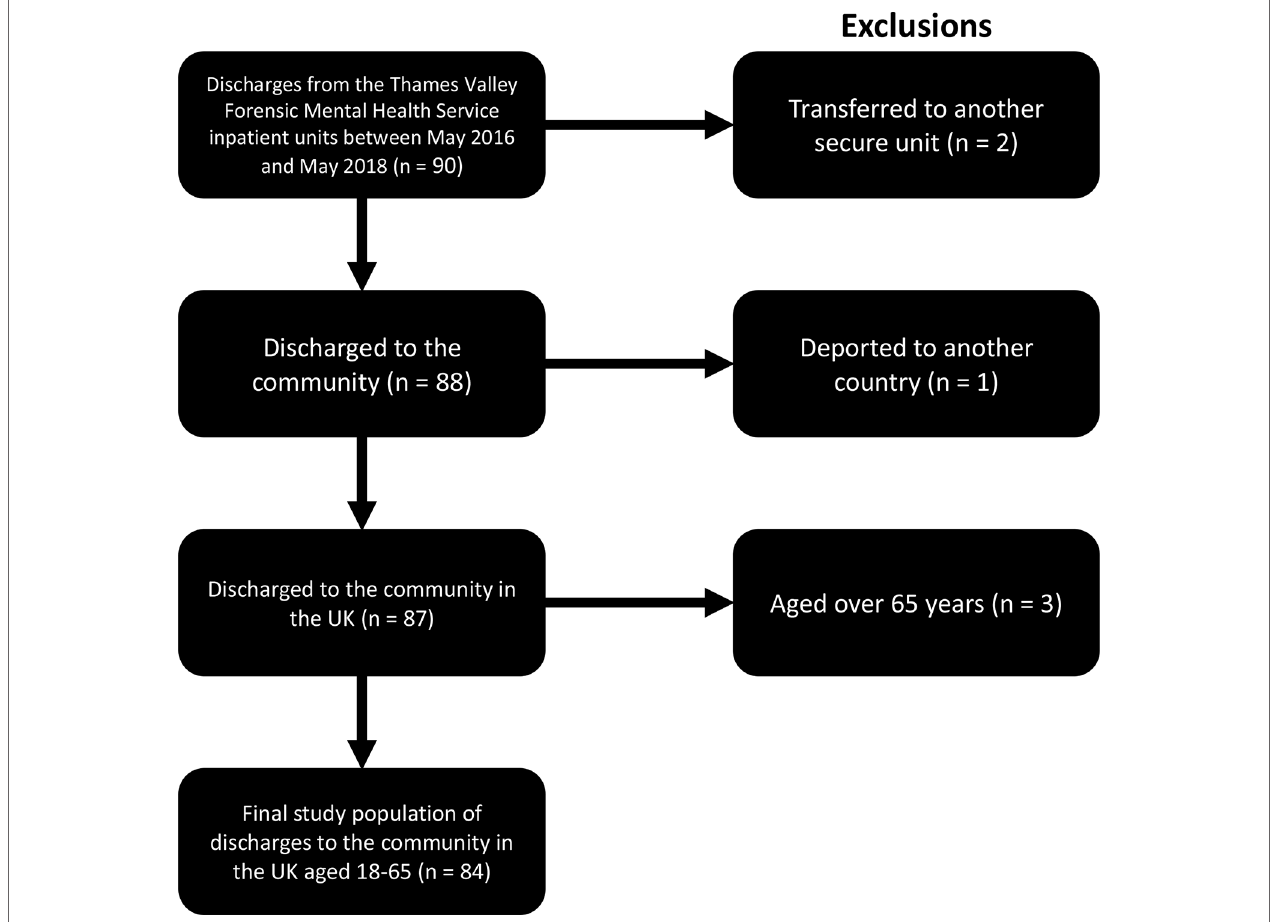
FigURe 1 | Inclusion of discharged patients from secure hospital into